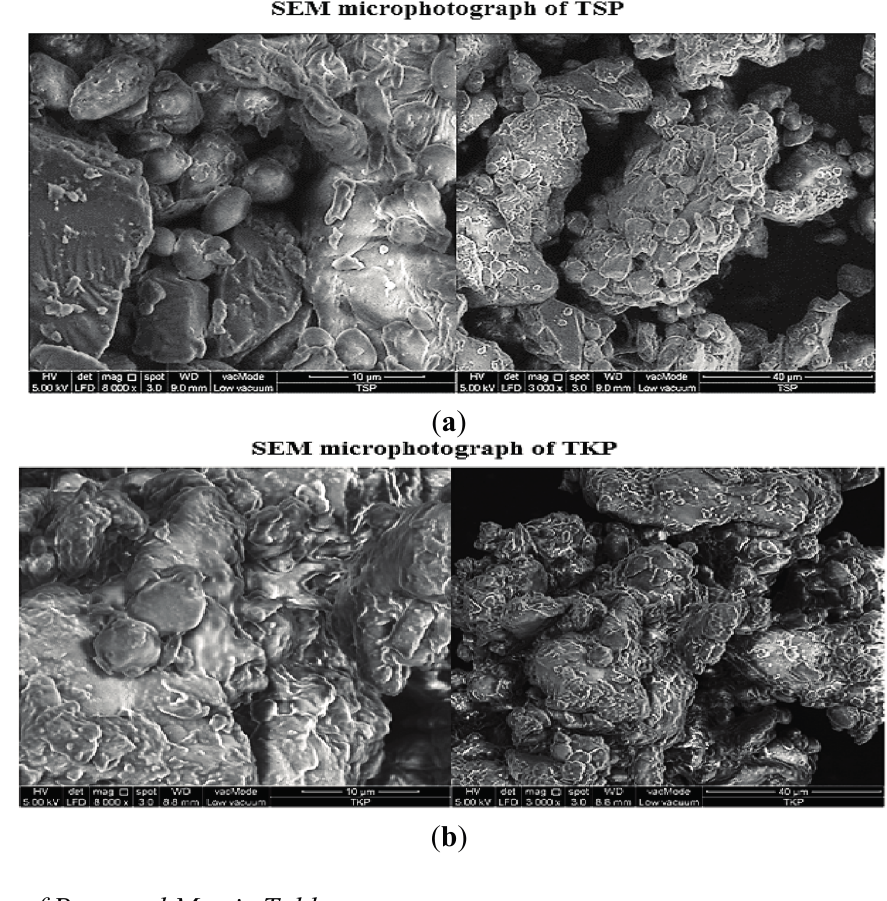
Figure 4. SEM microphotography of ( a ) TSP and ( b ) TKP (Magnification 3000 × and 8000 × , scale 40 and 10